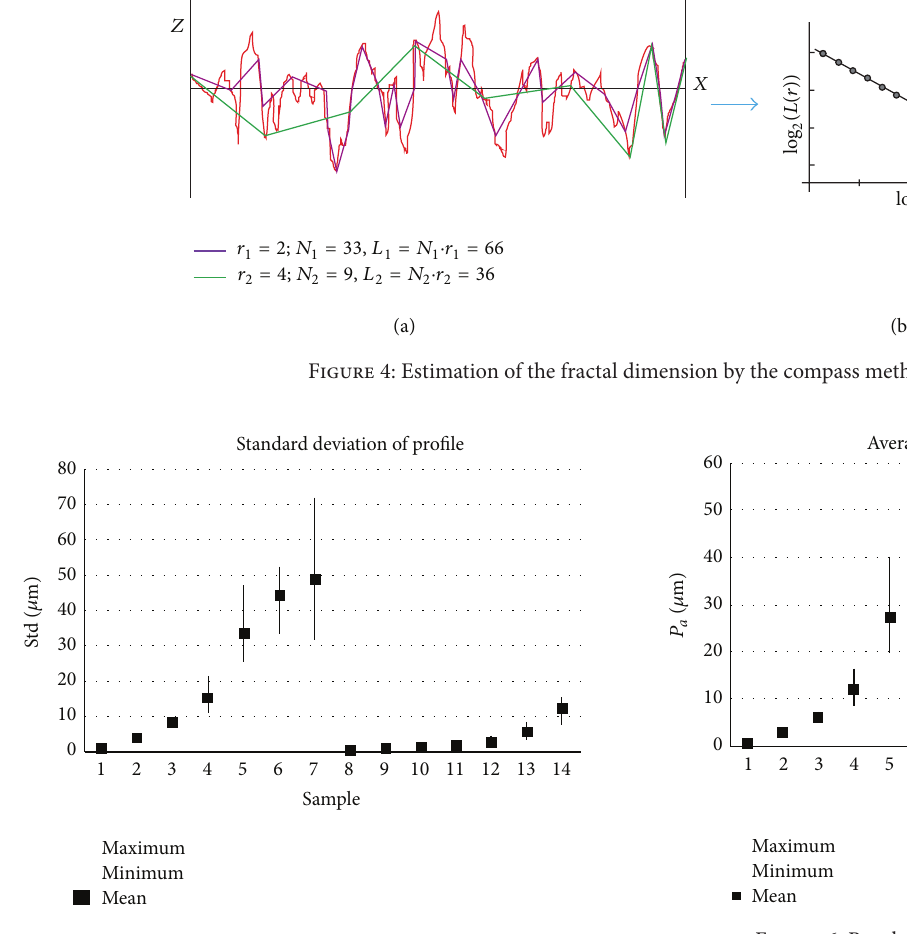
Figure 5: Results of parameter Standard deviation ( 𝑥 -axis). Figure 6: Results of 𝑃 𝑎 parameter ( 𝑥